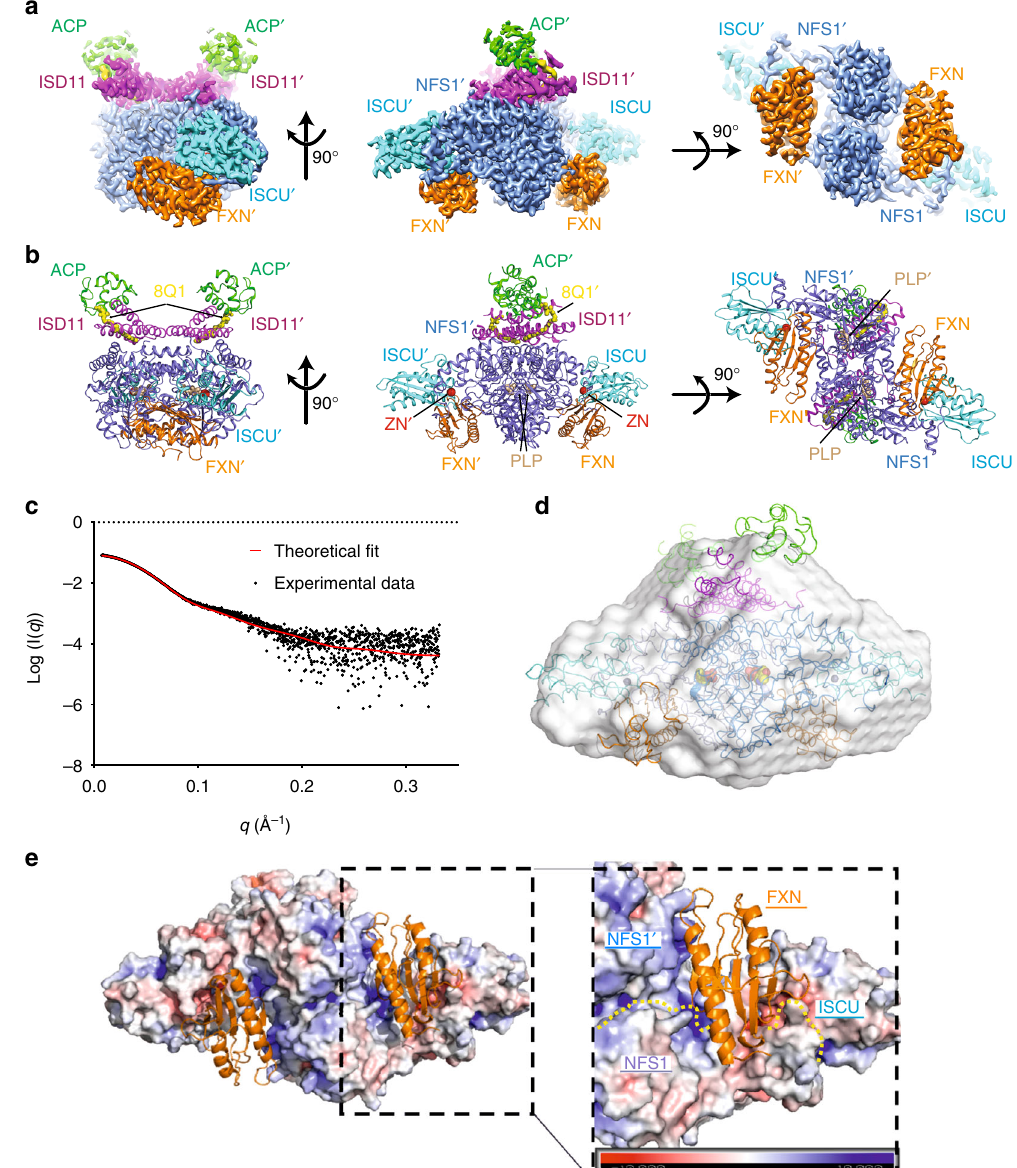
Fig. 1 SDAUF-Zn 2 + structure and FXN-NFS1 interactions. a . Cryo-EM density of SDAUF-Zn 2 + structure (NFS1/NFS1 ’ slate, ISD11/ISD11 ’ magenta, ACP/ ACP ’ light green, ISCU/ISCU ’ , Cyan, FXN/FXN ’ orange). b . Cartoon representation of SDAUF-Zn 2 + complex. 4 ′ -phosphopantetheine acyl chain (8Q1, yellow), Zn 2 + ion (ZN, red) and pyridoxal 5 ′ -phosphate (PLP, wheat) are shown as sticks/spheres. c . Scattering data from a sample of SDAUF used in cryo- EM was collected (black points) and fi t to the theoretical SAXS pro fi le back-calculated from the SDAUF-Zn 2 + cryo-EM structure (red line) with χ 2 = 1.98. d . The ab initio envelope calculated from SAXS data for the SDAUF sample was superimposed with the cryo-EM structure e . In the SDAUF complex, each FXN binds to a cavity formed by interface of NFS1 homodimer and one ISCU. FXN is shown as orange cartoon, while other subunits of the complex are shown as surface representation (colored by electrostatic potential). Yellow dotted lines denote protein boundaries. Source data for panel c are provided as a Source Data fi FXN Interactions with NFS1 dimer interface and C-terminus . form potential H-bonds with NFS1 Arg119 and Arg272 (Fig. 2a). The FXN(D124A) variant, aimed at abolishing these salt-bridges, FXN interacts with one NFS1 protomer via potential salt-bridges, binds SDAU with 4-fold weakened K d compared to wild-type and with the other NFS1 protomer through van der Waals con- (WT)(Table 1 and Supplementary Fig. 1d). FXN contacts the tacts (Fig. 2a). The salt-bridge interface, highly conserved across other NFS1 protomer, and ISCU, using the β -sheet ( β 1- β 5) sur- orthologues (Supplementary Fig. 9), involves an acidic ridge of face (Fig. 2a – d). In this interface, FXN directly contacts the NFS1 FXN 21 (end of α 1, loop α 1- β 1, start of β 1) and a positively- charged Arg-rich patch (Arg272-Arg277) on one NFS1 protomer loop containing the catalytic residue Cys381 (Cys-loop) (Fig. 2a), (Figs. 1d, 2a and Supplementary Fig. 8a, b). For example, FXN via hydrophobic interaction between FXN Trp155 and NFS1 Asp124 can potentially form salt-bridges with NFS1 Arg289, Leu386, and potential H-bond between FXN Asn146 and NFS1 while carbonyl backbones of FXN residues Glu121 and Tyr123 Ala384 carbonyl backbone. The clinical variant FXN(N146K)